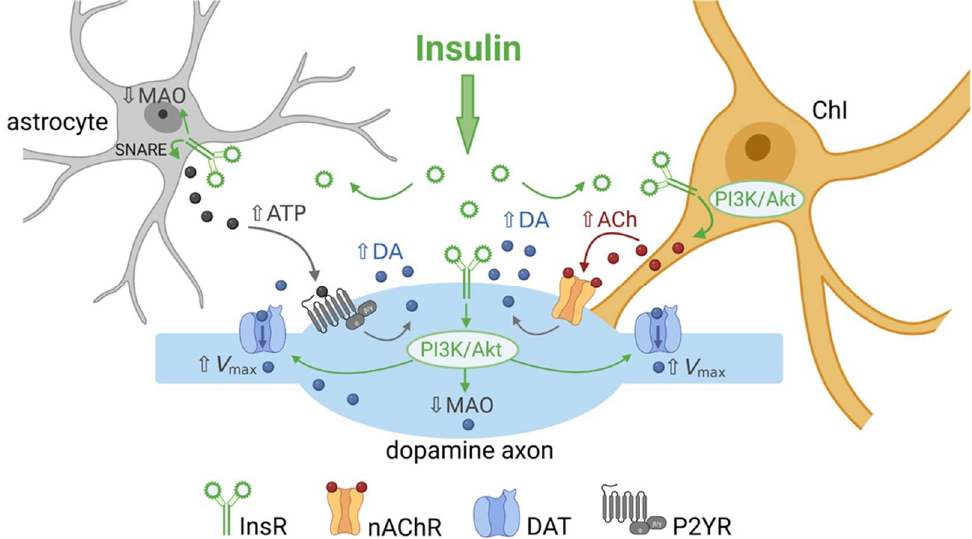
Figure 2. Summary of the multiple ways by which insulin can regulate striatal dopamine (DA) transmission. Activation of insulin receptors (InsRs) on cholinergic interneurons (ChIs) increases ChI excitability, which increases acetylcholine (ACh) release and activation of nicotinic ACh receptors (nAChRs) on dopamine axons to boost dopamine release and increase extracellular DA concentration ([DA] o ). Activation of InsRs on dopamine axons increases dopamine transporter (DAT) surface expression via the PI3K/Akt pathway to increase the maximum velocity ( V max ) of dopamine uptake, thereby lowering [DA] o . Activation of InsRs on astrocytes increases exocytotic ATP release, which activates purinergic P2Y receptors (P2YR) on dopamine axons and enhances dopamine release. Insulin also decreases monoamine oxidase (MAO) activity in dopamine axons and glial cells, thereby decreasing dopamine metabolism and prolonging the time course of dopamine actions.